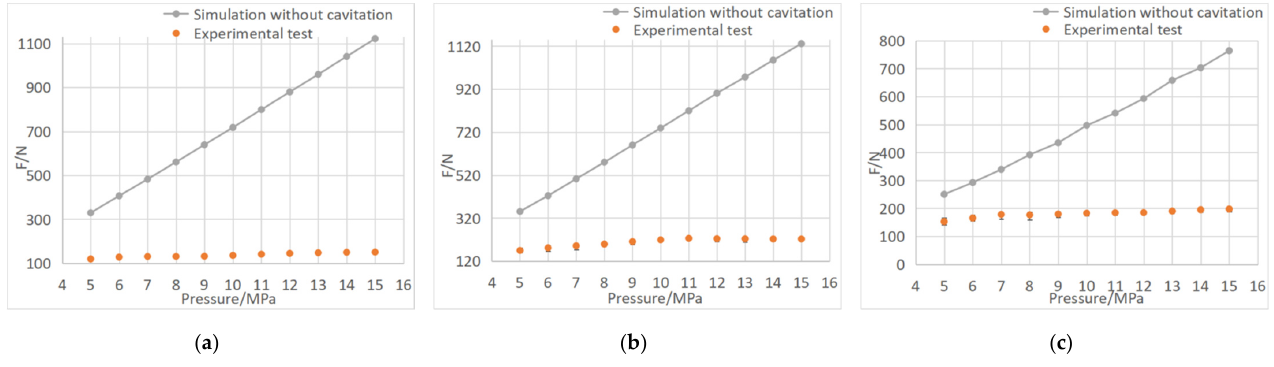
Figure 6. Comparison of suction force results of simulation with non-cavitation model and experiment of the original suction cup. Gap clearance is ( a ) 1 mm; ( b ) 1.5 mm; ( c ) 2 mm.